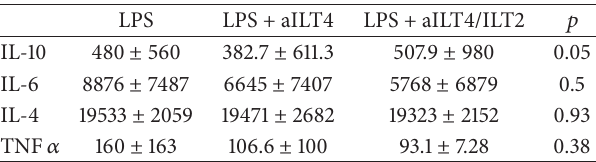
Table 3: Effect of activation of ILT4 and/or ILT2 on cytokine release by DC from SLE